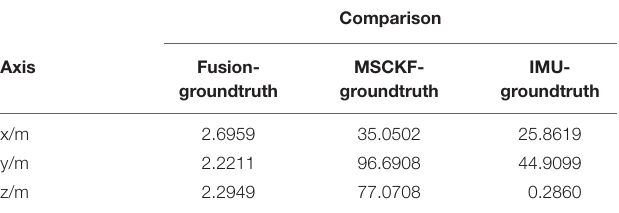
FIGURE 18 | Comparison of the overall trajectory in z -axis after VIO failure and when all sensors are working normally.